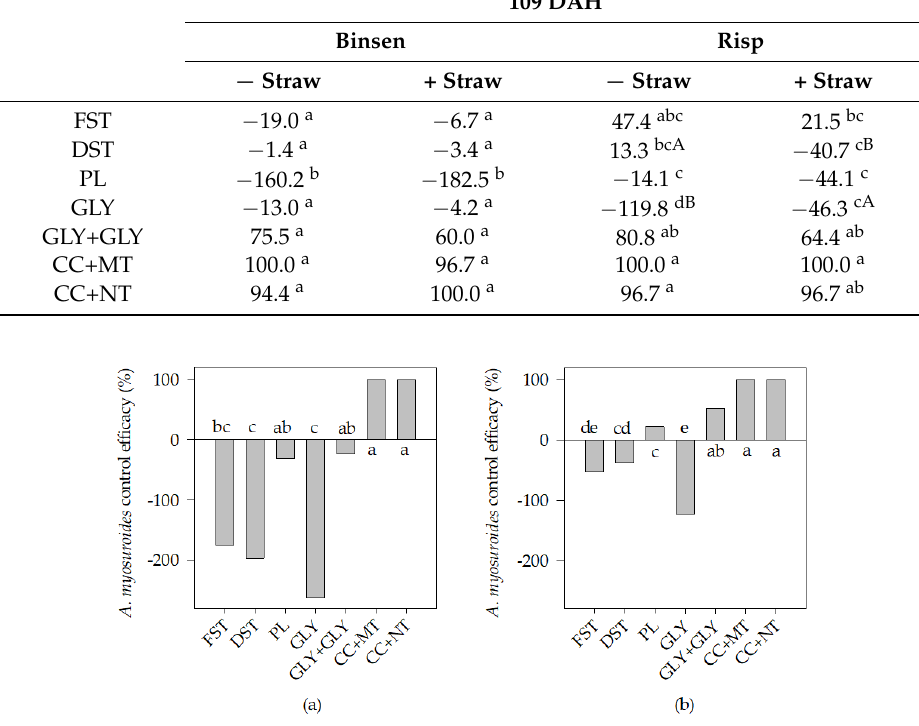
Figure 2. Average Alopecurus myosuroides Huds. ( A. myosuroides ) control efficacy of flat soil tillage (FST), deep soil tillage (DST), ploughing (PL), single glyphosate application (GLY), dual glyphosate application (GLY+GLY), cover crop mixture + mulch-till (CC+MT) and cover crop mixture + no-till (CC+NT) treatments at the fields ( a ) Binsen and ( b ) Risp 135 days after harvest. Different small letters within one graph show significant differences according to the Tukey-HSD test ( p ≤ 0.05). Means with identical letters do not differ significantly.